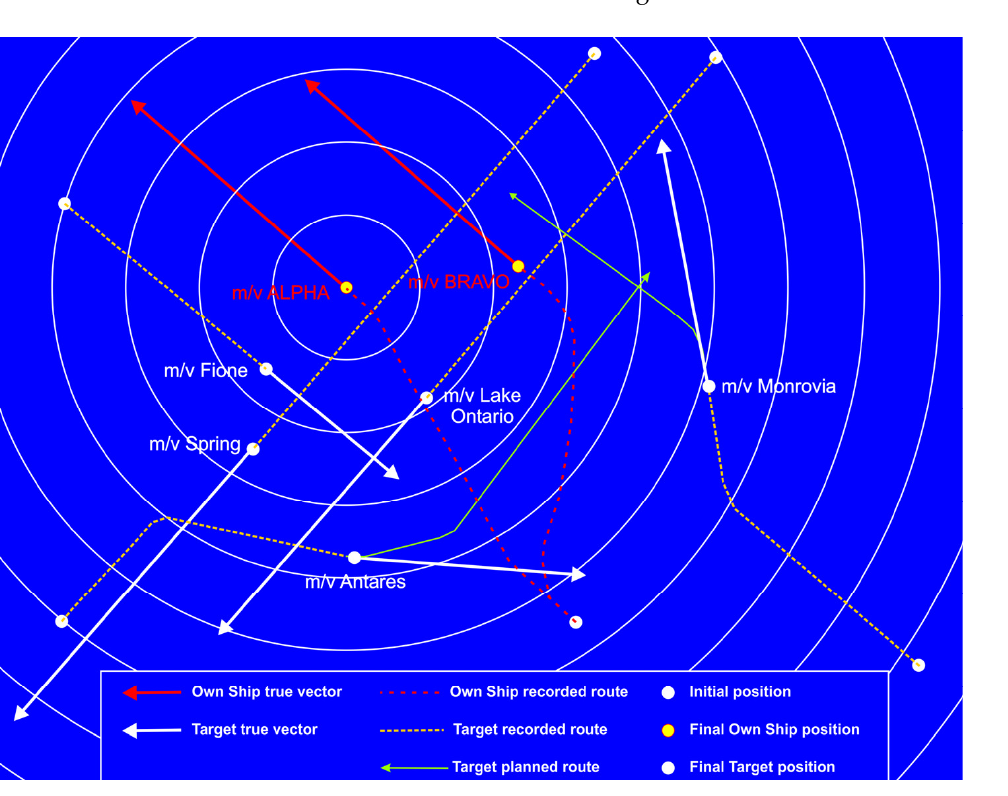
Figure 7. Final situation at the end of the simulation (for ships ALPHA and BRAVO).